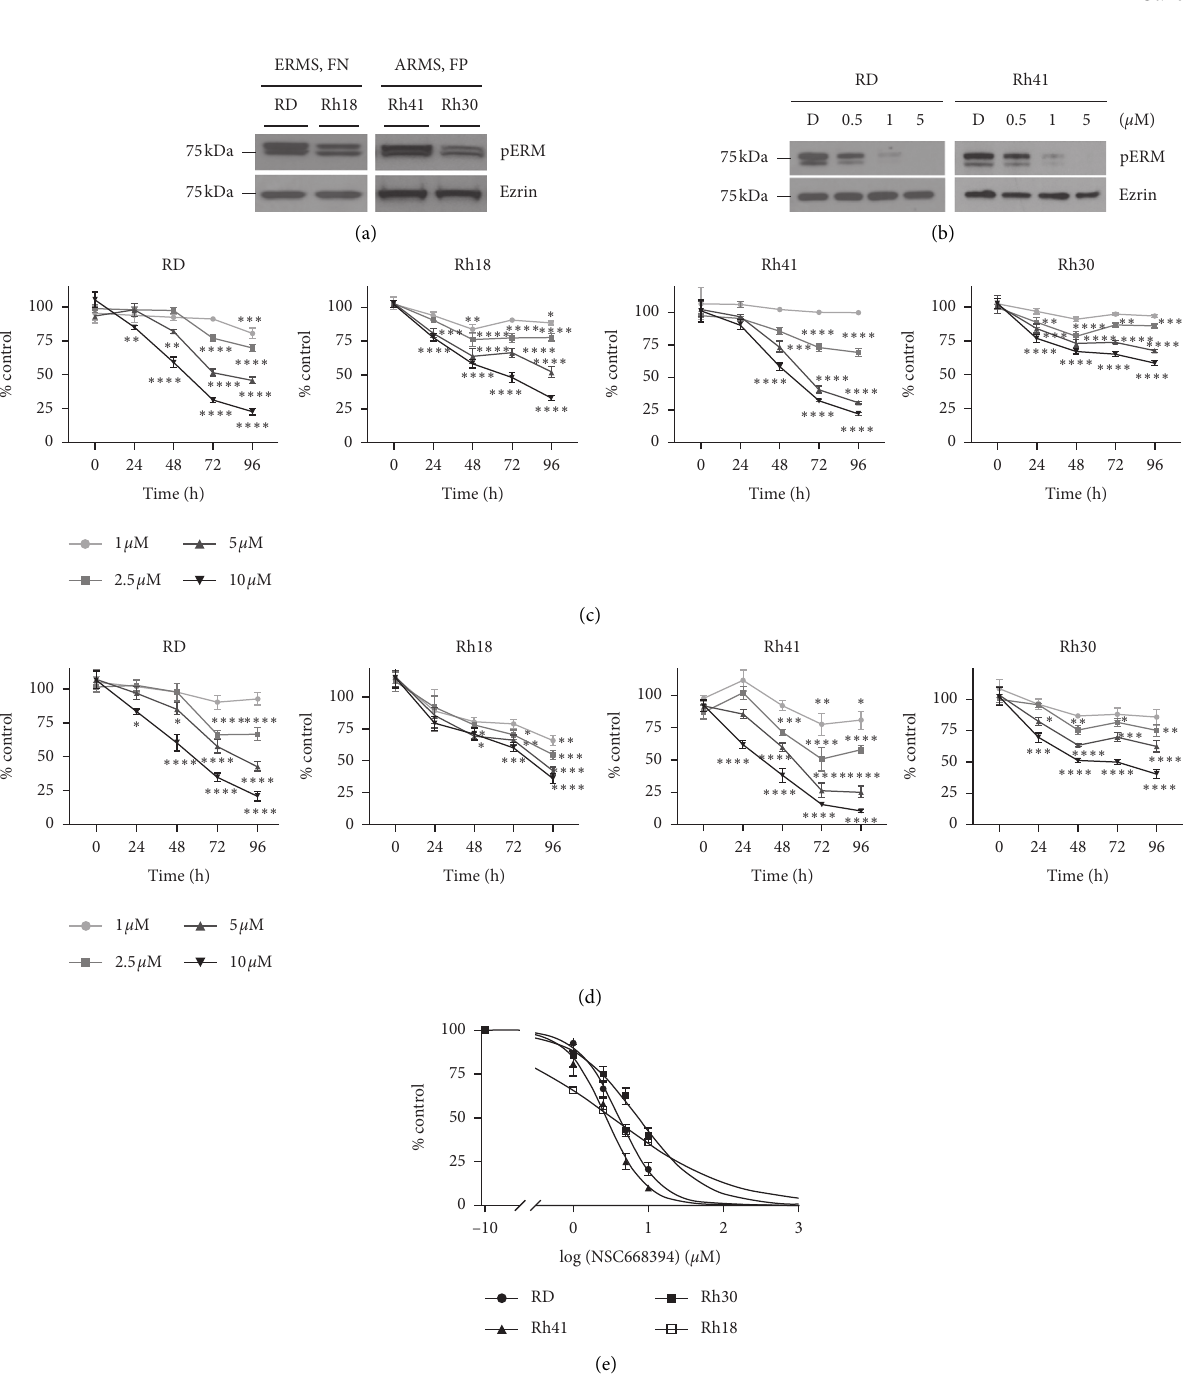
Figure 1: NSC668394 dephosphorylates ezrin and reduces cell viability and metabolism in RMS cells. (a) Western blot showing levels of phosphorylated ezrin-radixin-moesin (pERM) and total ezrin in untreated RMS cell lines. (b) Levels of pERM and total ezrin in RD and Rh41 whole cell lysates following treatment with indicated concentrations of NSC668394 or DMSO (D) for 1h. (c) RMS cell viability following treatment with increasing concentrations of NSC668394 for 0–96h as determined by trypan blue (d) RMS cell metabolism following treatment with increasing concentrations of NSC668394 as determined by MTTassay. (e) Variable slope nonlinear regression of 96h MTT data was used to extrapolate IC50 values for inhibition of cell metabolism. All individual data points are represented as mean ± SEM and are representative of at least three independent experiments. Asterisks represent a significant difference between vehicle control DMSO and NSC668394 treated groups ( ∗ p < 0 . 05, ∗∗ p < 0 . 005, ∗∗∗ p < 0 . 0005, and p < 0 . 0001 � ∗∗∗∗ ) for the given time point as determined by two-way ANOVA with Dunnett’s multiple comparisons